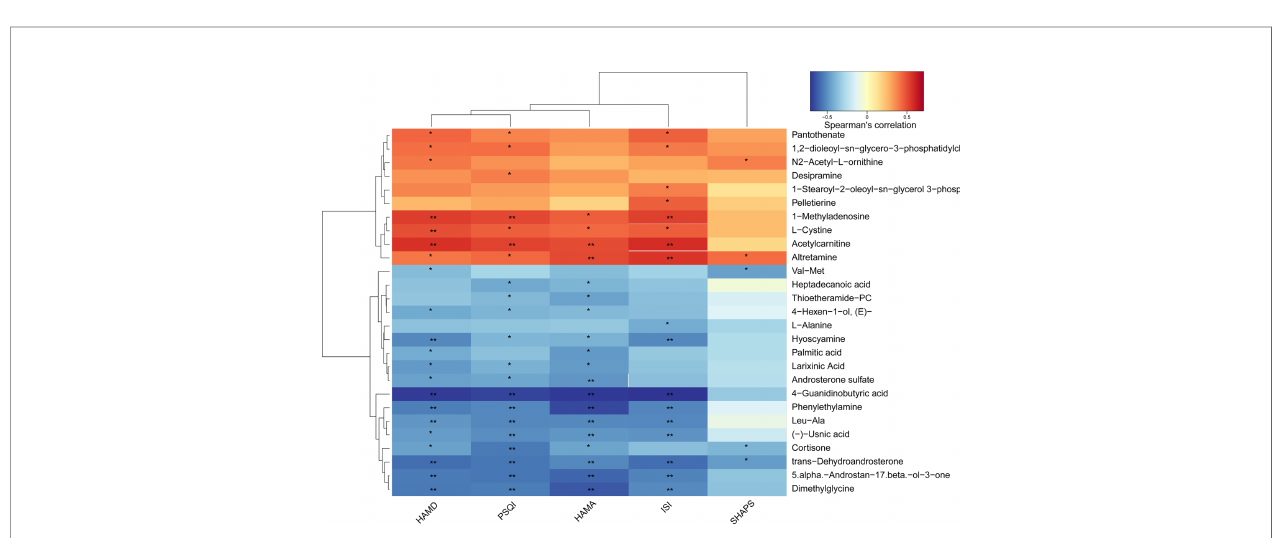
FIGURE 8 | Heat map of the Spearman correlation analysis between serum metabolites and sleep/mood index. * P < 0.05; ** P < 0.01. PSQI, Pittsburgh Sleep Quality Index; ISI, Insomnia Severity Index; HAMA, Hamilton Anxiety Rating Scale; HAMD, Hamilton Depression Rating Scale; SHAPS, Snaith-Hamilton Pleasure